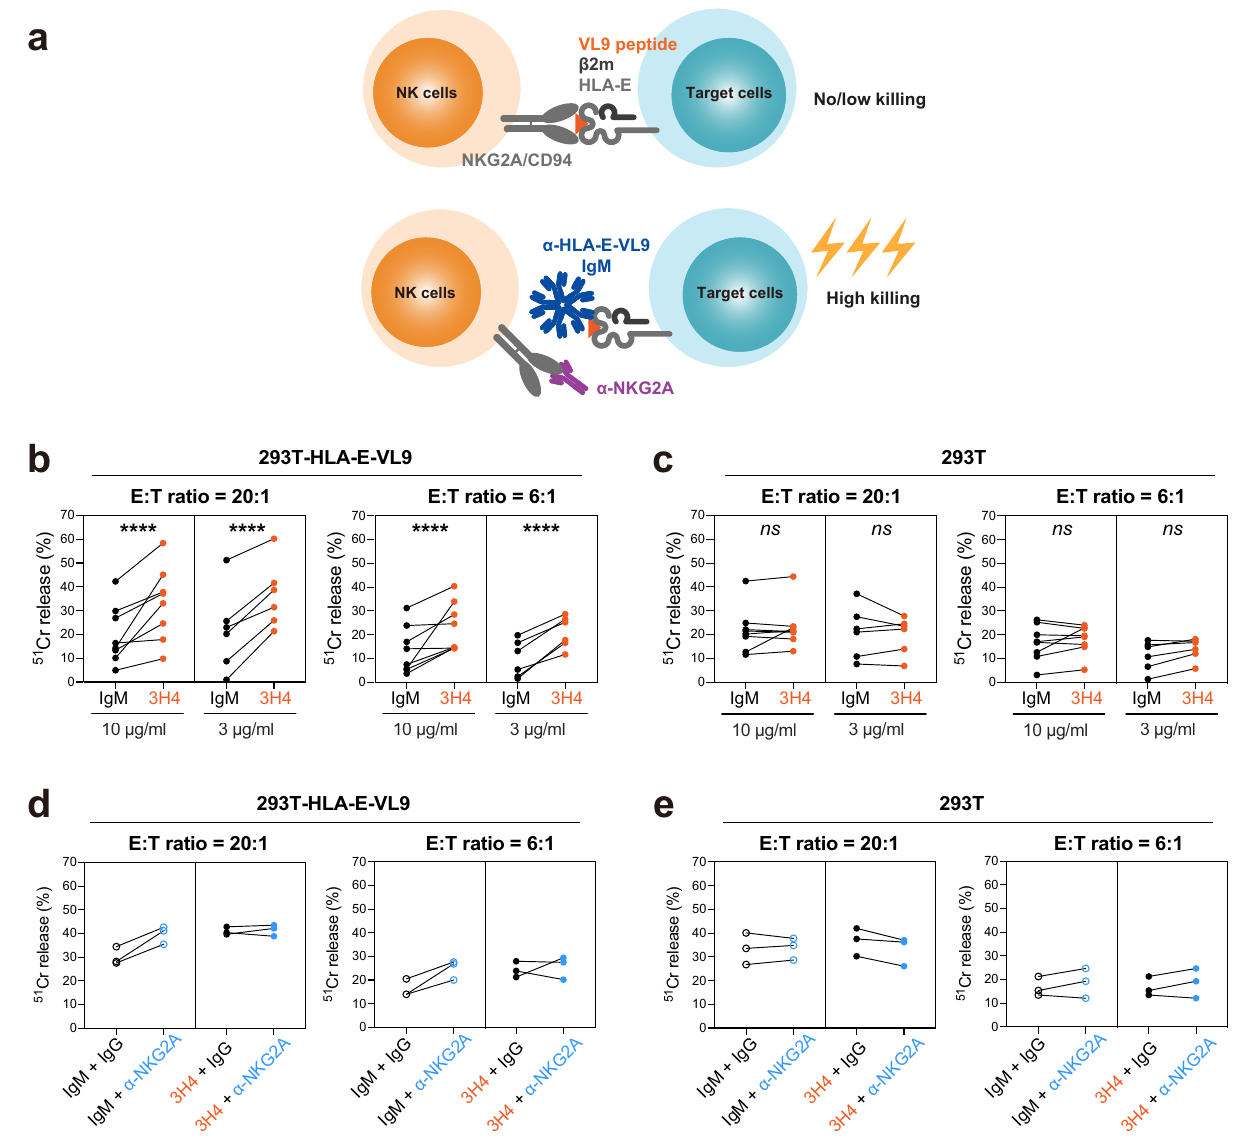
Fig. 3 MAb 3H4 enhanced the cytotoxicity of the NKG2A + NK cell line NK-92 against HLA-E-VL9-expressing 293T cells. a Schematic illustrating the hypothesis. Blockade of the inhibitory NKG2A/CD94/HLA-E pathway with anti-HLA-E-VL9 antibody (3H4) and/or anti-NKG2A antibody (Z199) could enhance target cell lysis by NK cells. b , c NK cell cytotoxicity against 3H4 IgM-treated target cells as assessed by 51 Cr release assay. Antibody was incubated with HLA-E-VL9-transfected 293T cells ( b ) and untransfected 293T cells ( c ) at fi nal concentration of 10 μ g/ml or 3 μ g/ml, and NK92 cells were added into the mixture as effector cells at effector: target (E:T) ratios of 20:1 and 6:1. Mouse IgM MM-30 was used as an isotype controls. Dots represent the mean values of triplicate wells in eight independent experiments. Statistical analysis was performed using mixed effects models. Asterisks show the statistical signi fi cance between indicated groups: ns, not signi fi cant, * P < 0.05, ** P < 0.01, *** P < 0.001, **** P < 0.0001. d , e NK cell cytotoxicity in the presence of anti-NKG2A mouse IgG Z199 in combination with TE4 control- or 3H4-treated target cells as assessed by 51 Cr release assay. Antibody combinations of Z199 + IgM control ( d ) or Z199 + 3H4 ( e ) were incubated with HLA-E-VL9-transfected 293T cells and untransfected 293T cells at a fi nal concentration of 10 μ g/ml, and NK92 cells were added into the mixture as effector cells. Dots represent the mean values of triplicate wells in three independent